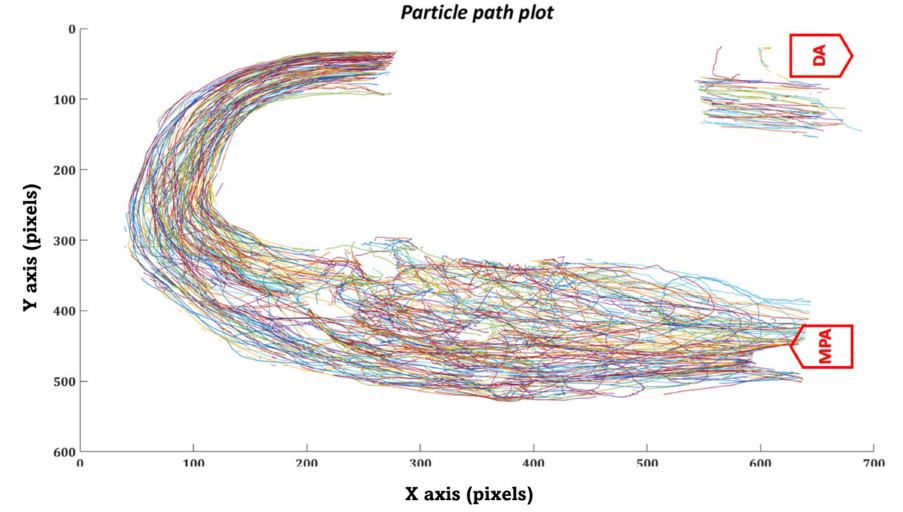
Figure 27. Trajectory plot of tracked particles in the MPA conduit for patient 1.